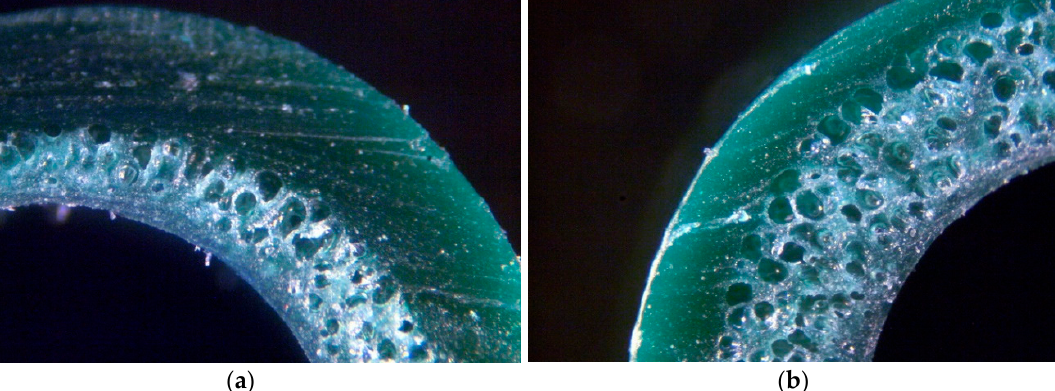
Figure 6. Fragment of the cross section of of the double coatings: ( a ) PVC + 0.2% BA; ( b ) PVC + 0.6% BA.